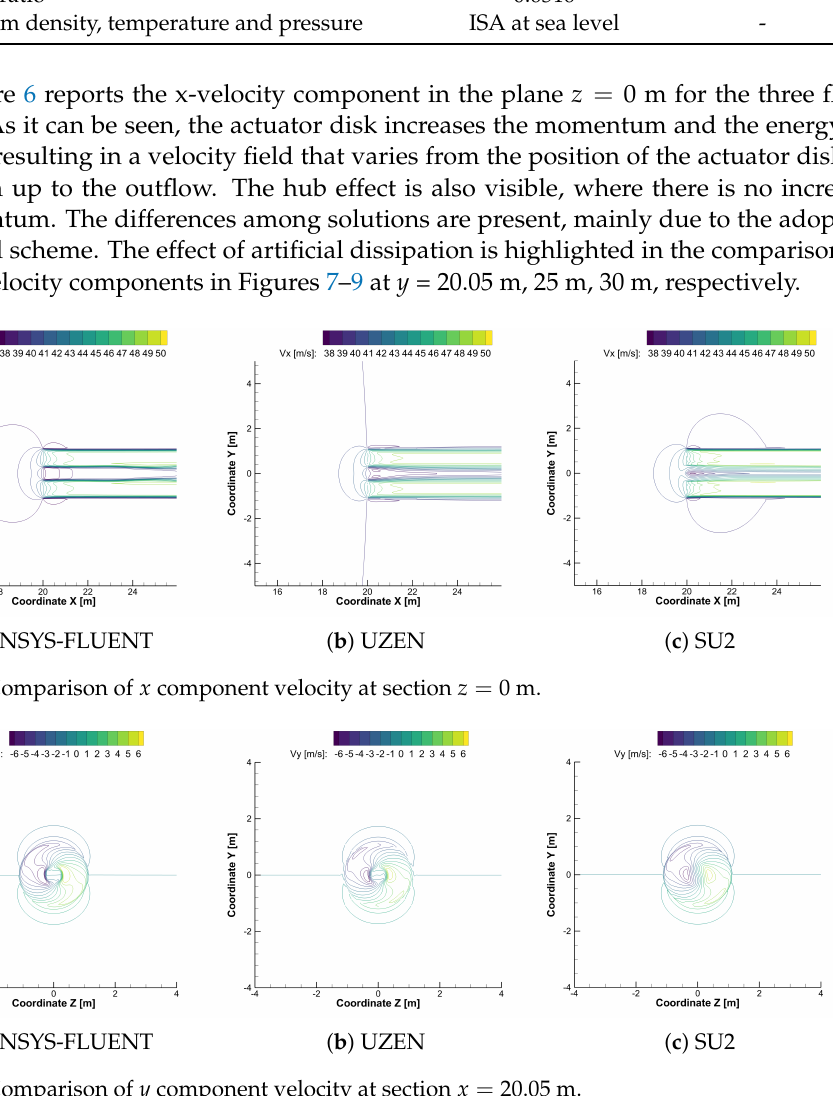
Figure 7. Comparison of y component velocity at section x = 20.05 m.